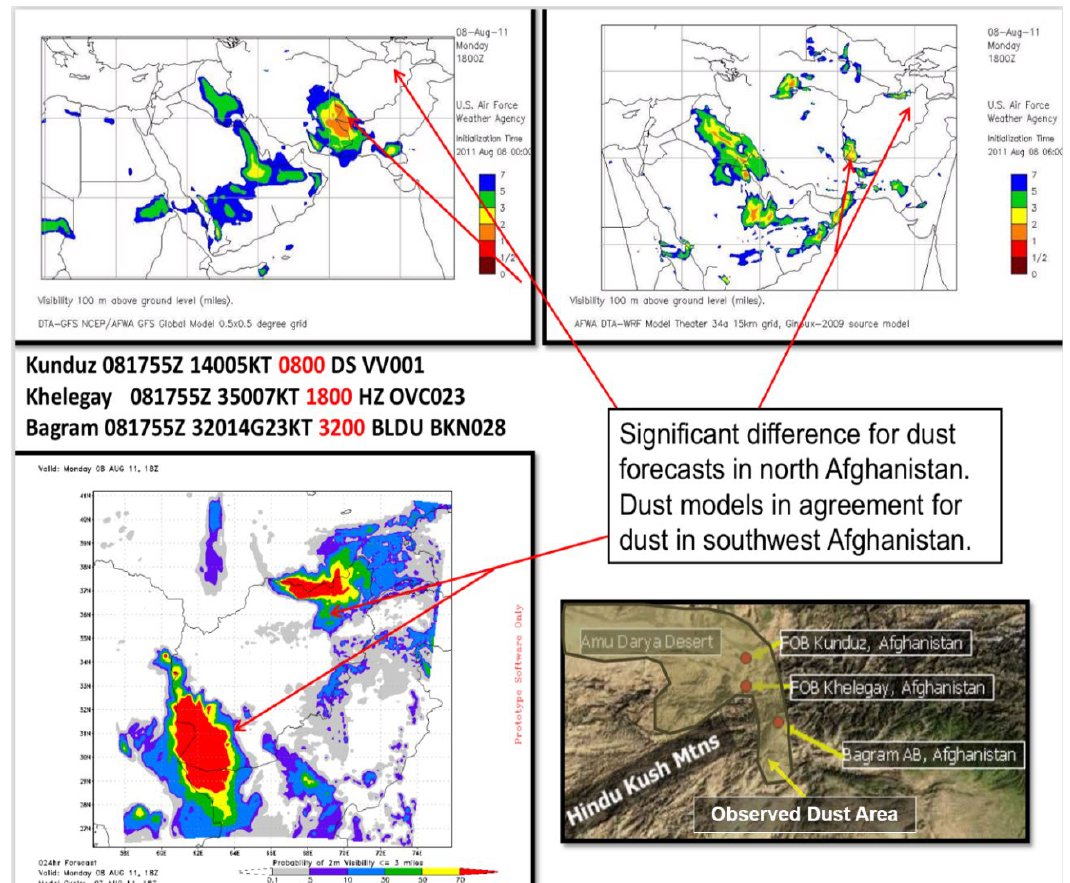
Figure 12. Forecaster-submitted review of a visibility-reducing dust event in Afghanistan. Top are 18-hour visibility forecasts from a post-processing dust advection model (Barnum et al. 2004) using GFS (left) and 15-km WRF (right) inputs. Bottom left is the 24-hour probability (percent) of visibility less than 3 miles (4.8 km) from the 4-km MEPS with explicit dust modeling. Bottom right is a terrain map of the area of interest in Afghanistan with military locations of interest. All forecasts valid at 1800 UTC on 08 Aug 2011.